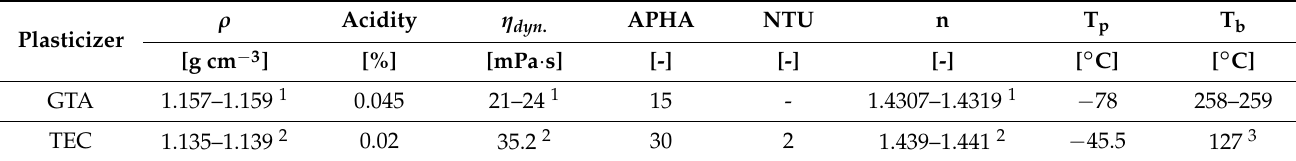
Table 1. Characteristic data of the plasticizers used.